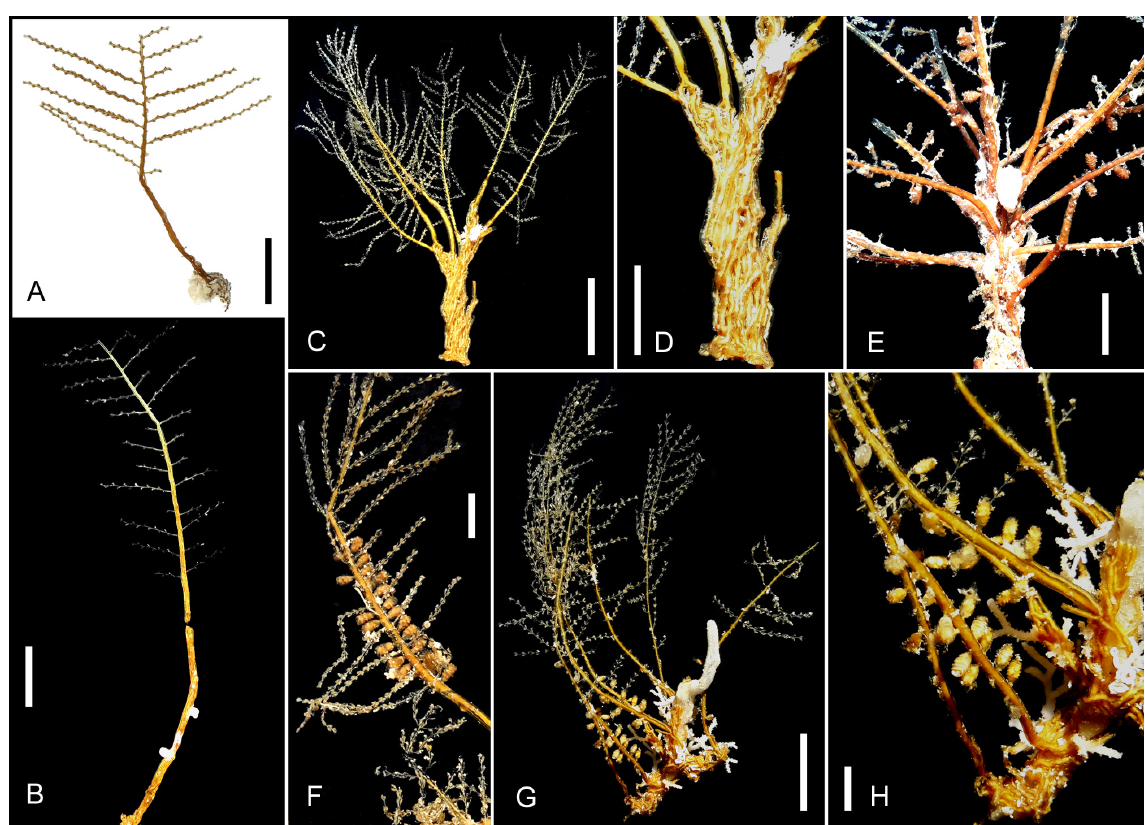
Fig. 6. A . Hincksella immersa Galea, sp. nov., holotype colony, MNHN-IK-2015-390. — B . Hincksella sibogae Billard, 1918, one colony from sample MNHN-IL-2015-391. — C–F . Synthecium hians